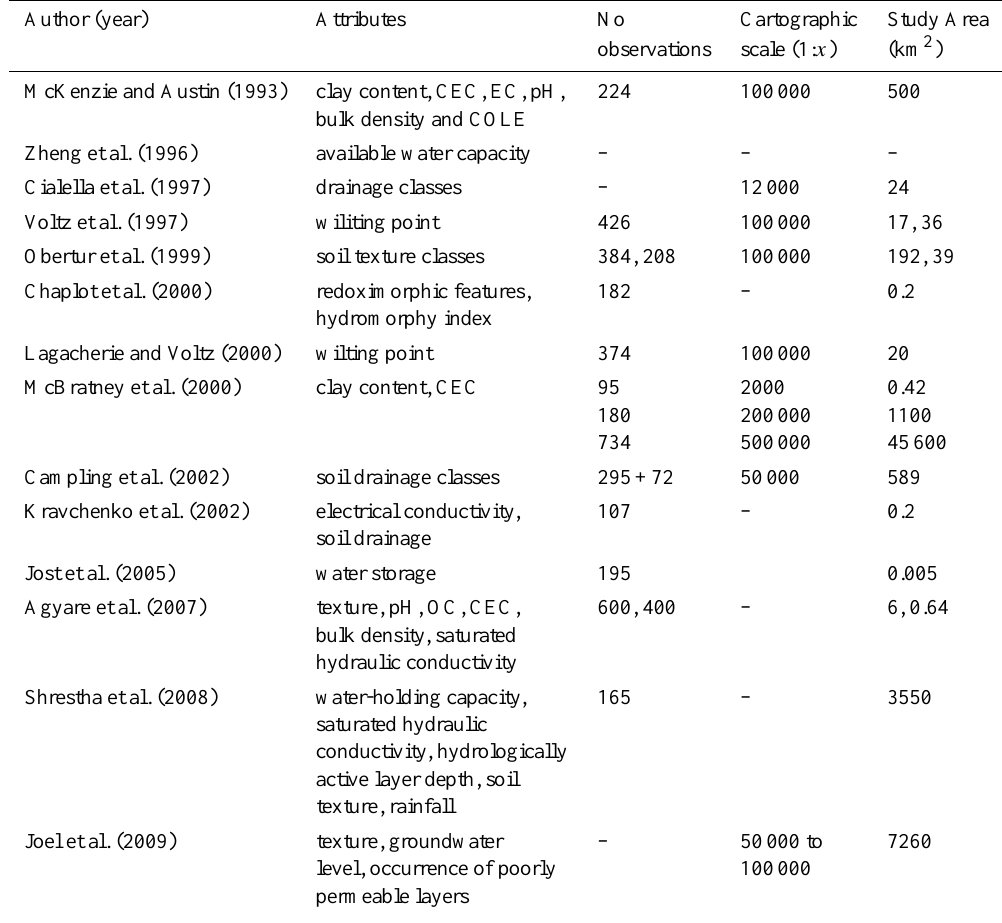
Table 1. Selection of works involved in soil mapping and hydrologically relevant